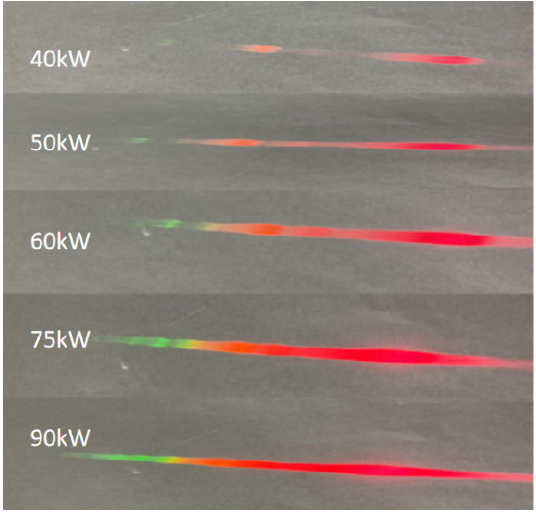
Figure 5. Evolution of visible light with increasing input peak power after 10 m GRIN fiber.